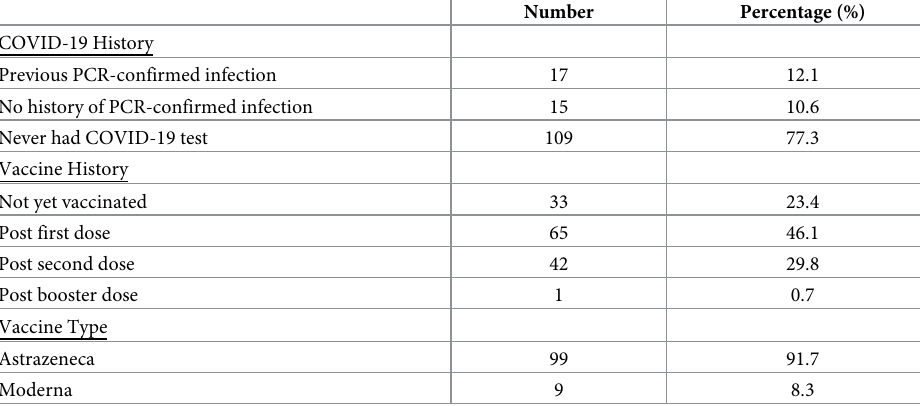
Table 2. History of COVID-19 and vaccine uptake in the study